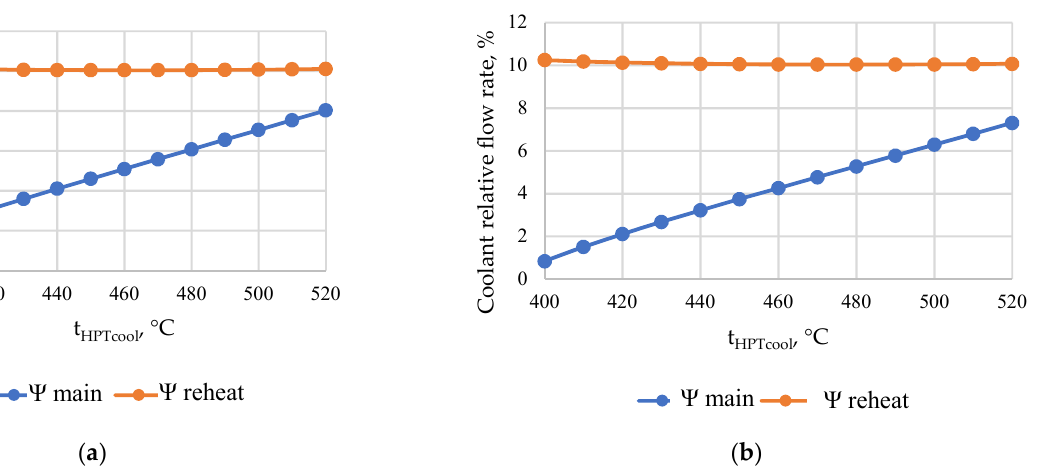
Figure 5. HPT and IPT relative coolant flow rates at different coolant temperatures and coolant production methods for HPT: ( a ) Mixing of main steam and feed water; ( b ) steam extraction from the boiler header.